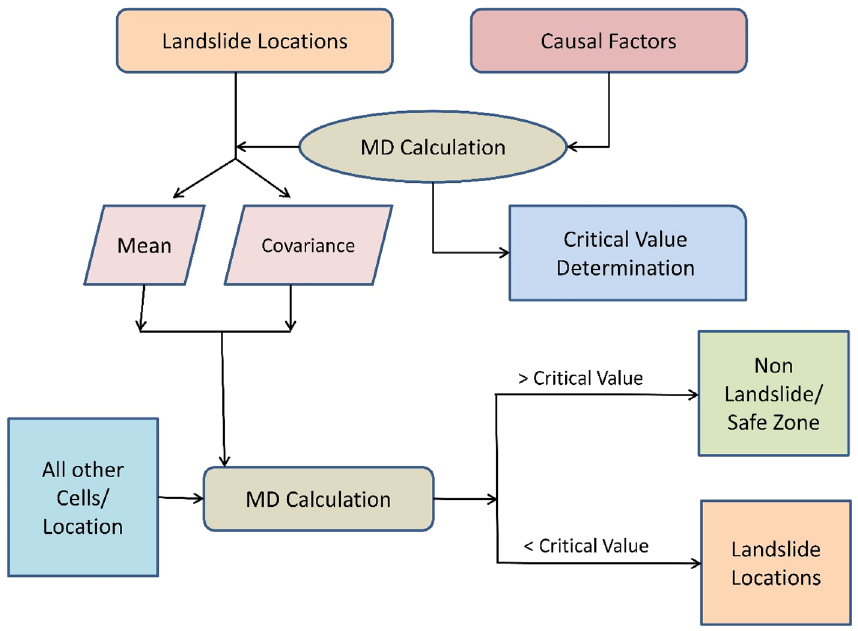
Figure 1. Flow chart of the MD based absence-data